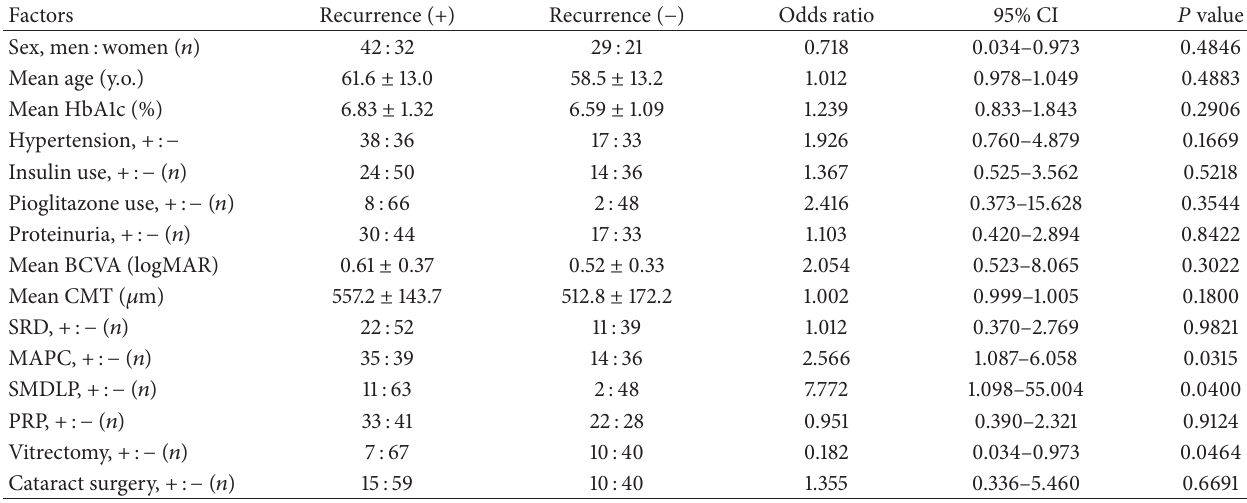
Table 2: Multiple logistic regression analysis of a recurrence and/or persistence of DME after